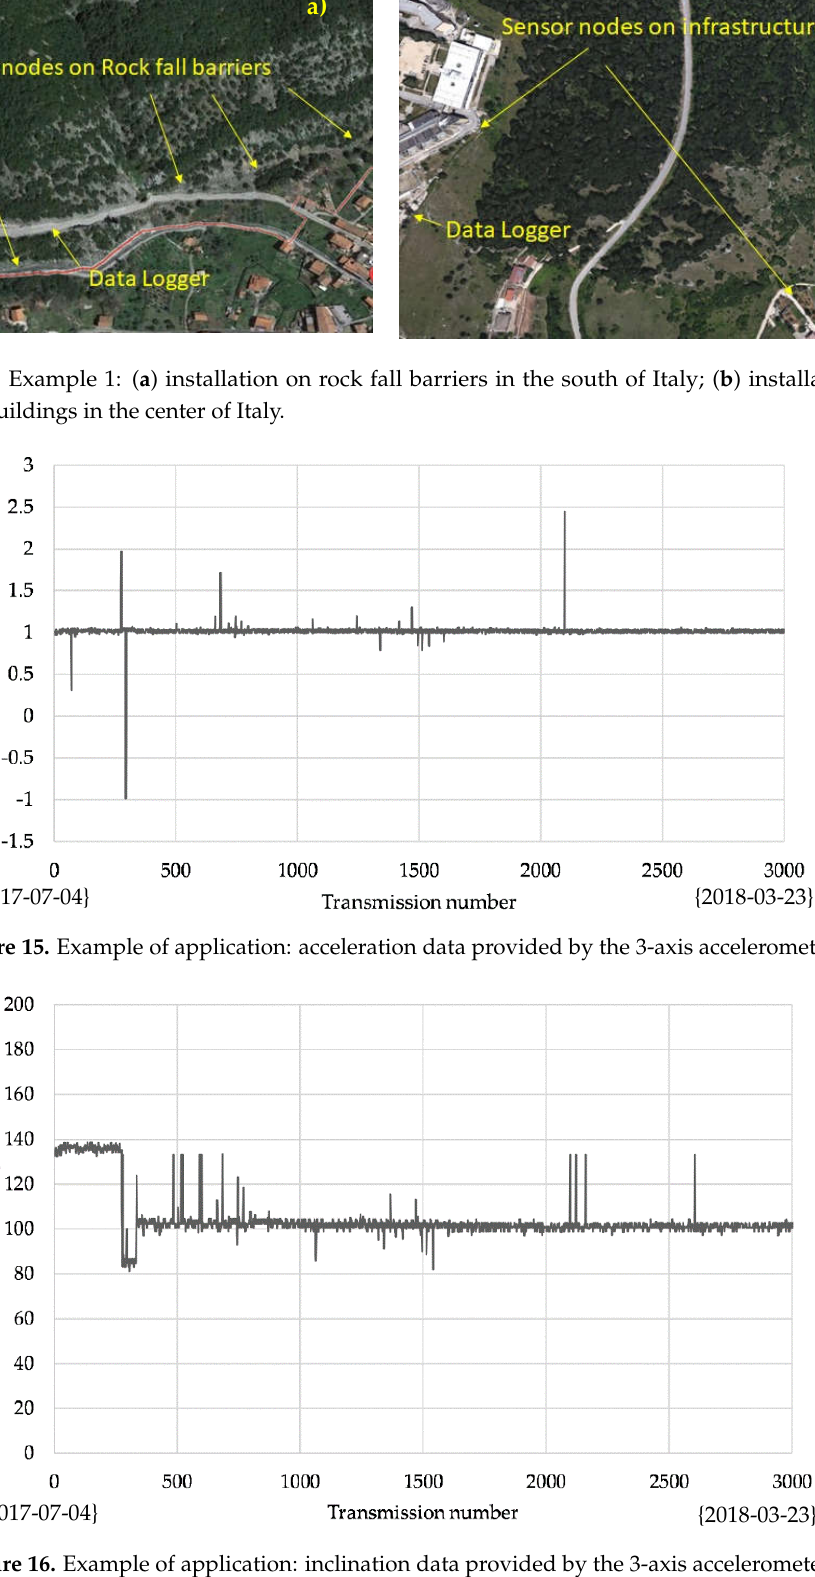
Figure 16. Example of application: inclination data provided by the 3-axis accelerometer.